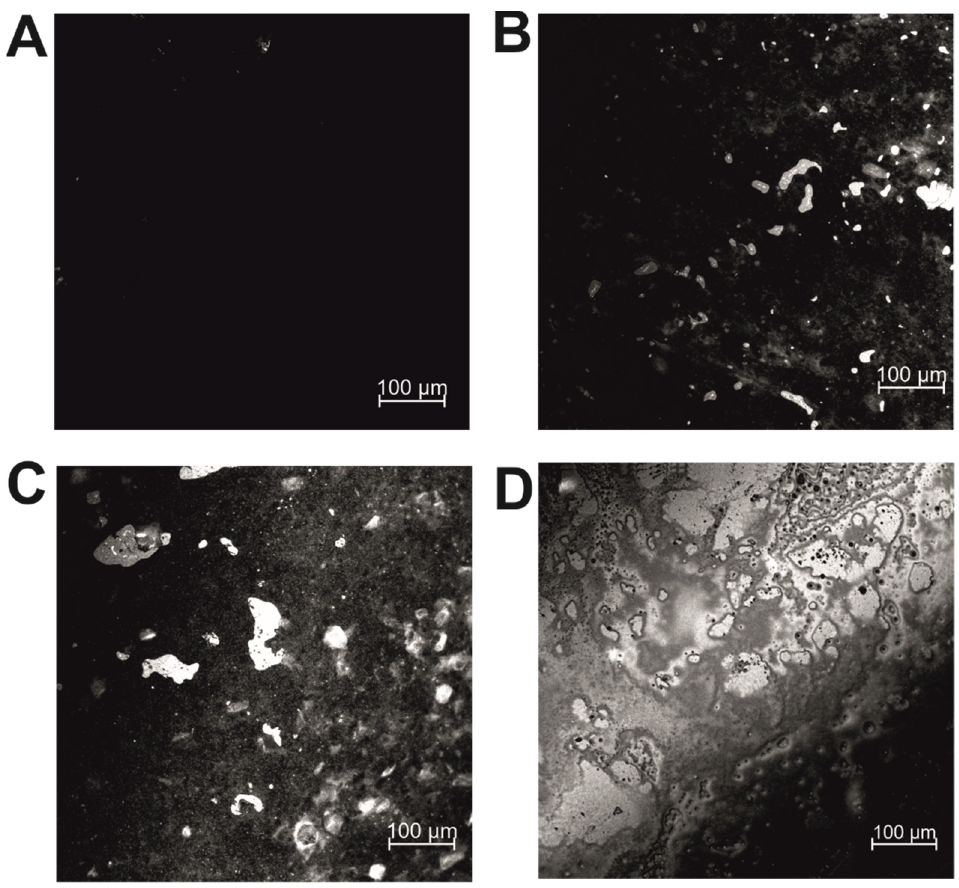
Figure 3. Confocal imaging of the PSI-biofunctionalized SLG/FTO electrodes. ( A ) FTO/SLG/pyr- NTA-Ni device used as a negative control. ( B ) FTO/SLG/pyr-NTA-Ni/PSI device. ( C) , FTO/SLG/pyr- NTA-Ni/cyt c 553 /PSI device, as analyzed in [37]. ( D) , FTO/SLG/pyr-NTA-Ni/His 6 -PsaD-PSI sample. The visualized surface area was ~0.41 mm 2 . Excitation was at 639 nm. Scale bar is 100 µm.